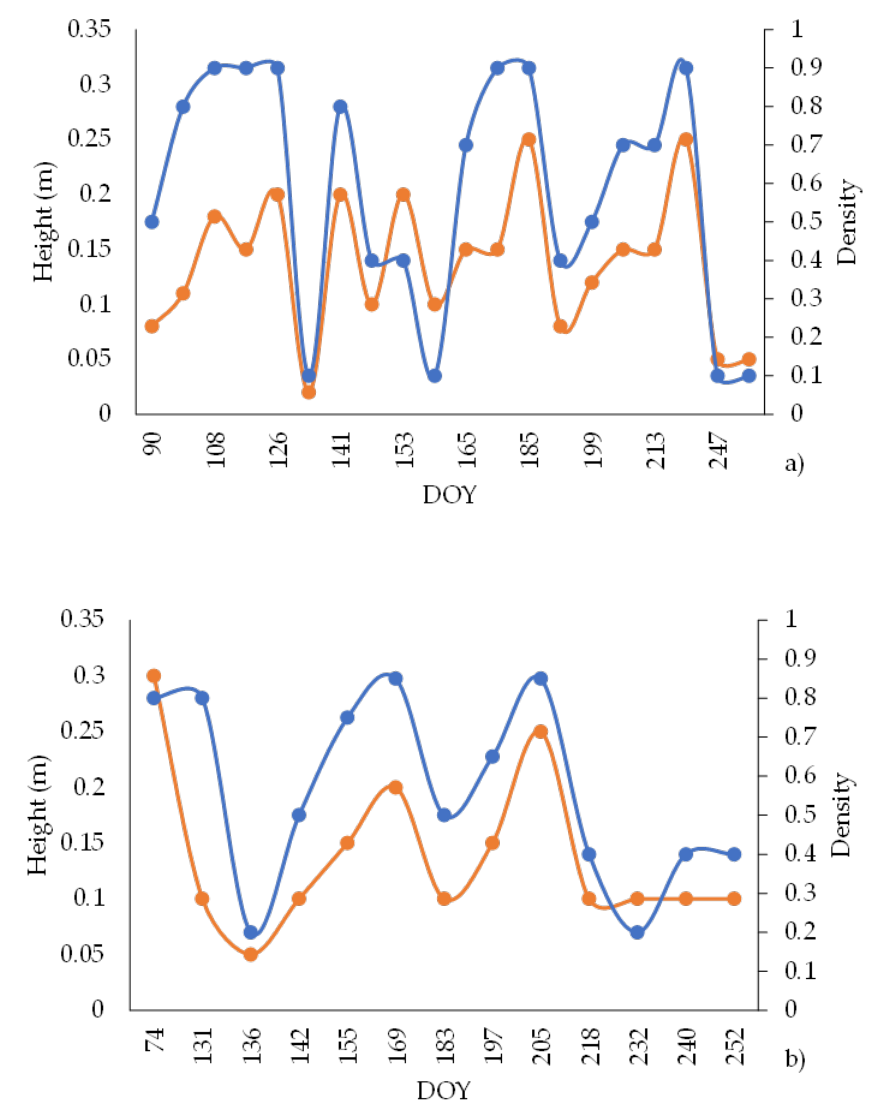
Figure A1. Evolution of active ground height ( ) and density ( ) in the vineyard inter-row relative to: ( a ) 2019, ( b ) 2020.